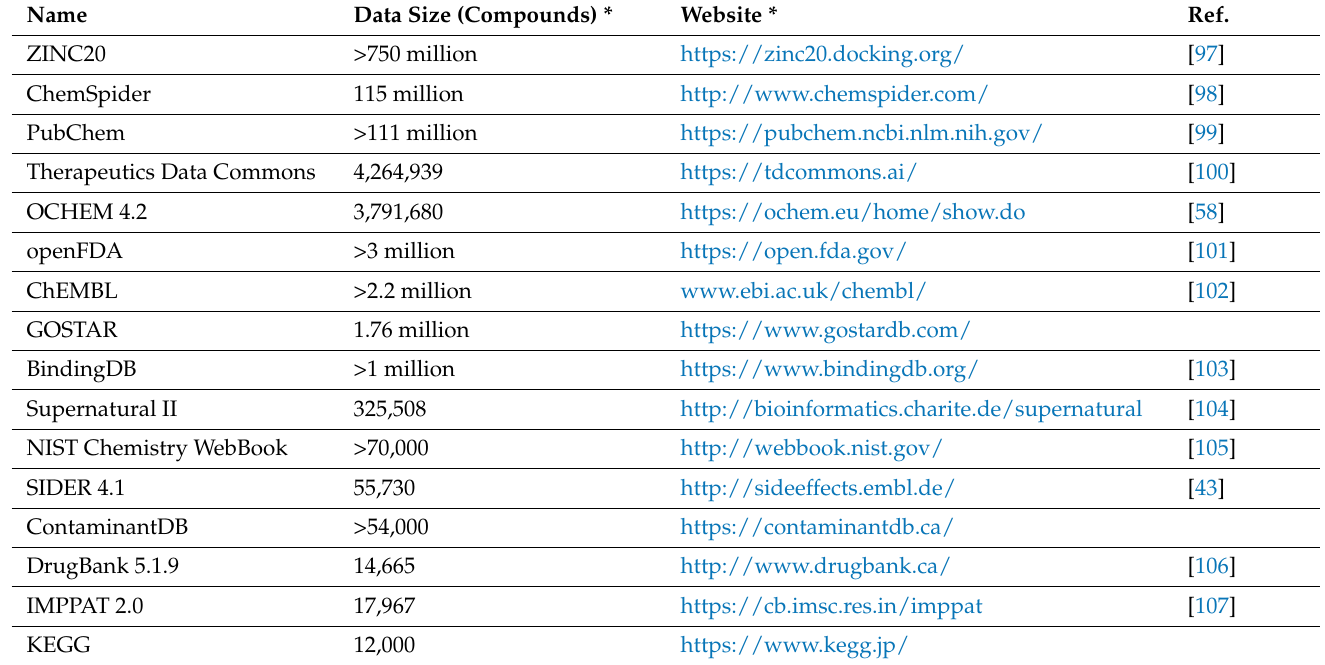
Table 7. Public data sources for AI-based distribution prediction